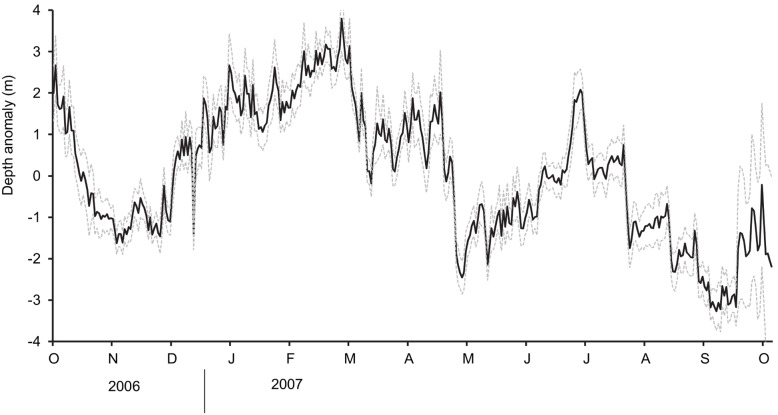
Mean daily depth anomaly for blue rockfish.Mean daily depth anomaly (solid black line) for 20 blue rockfish from 1 October 2006 through 30 September 2007. Grey dashed lines above and below the solid black line indicate ± SE. A daily depth anomaly was obtained by subtracting the annual mean depth of a given fish from the daily mean depth of that fish on each date of the study. Mean daily depth anomalies were obtained by averaging the depth anomaly for all fish on each date. Positive anomalies represent deeper mean depth than the annual mean depth; negative anomalies represent shallower mean depth than the annual mean depth.